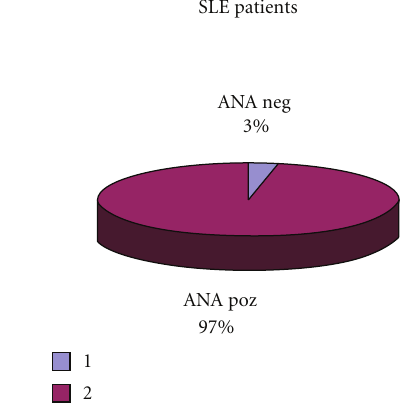
Figure 6: It presents number patients of positive and negative ANA testing’s.